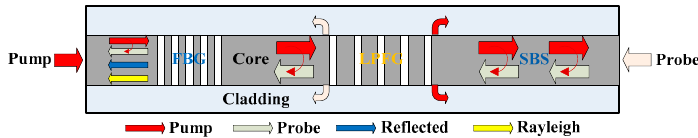
Figure 1. A schematic diagram of the hybrid BOTDA/XFG sensor on a single fiber.